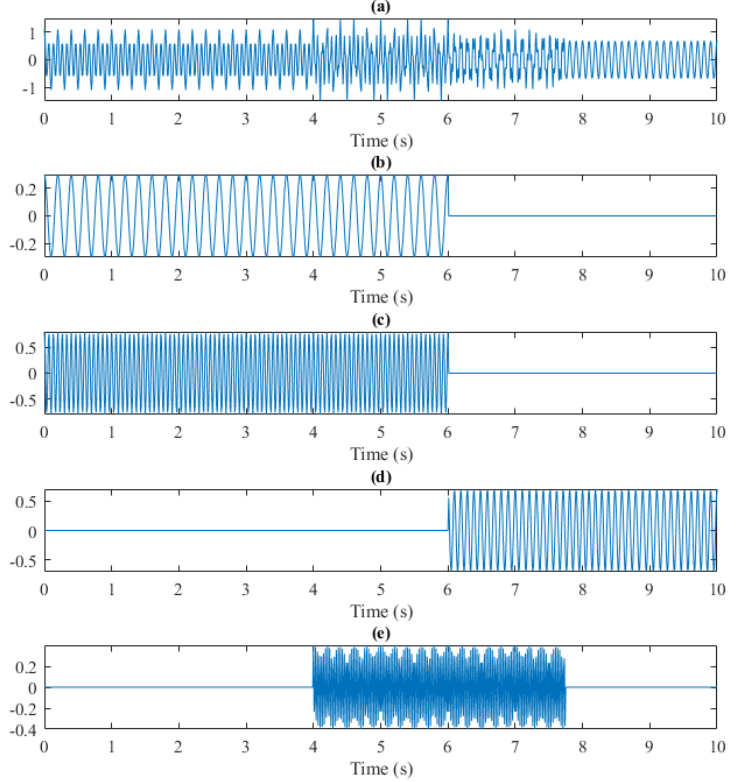
Figure 2. The synthetic data ( a ) composed of four sub-components ( b – e ). Remote Sens. 2018 , 10 , x FOR PEER REVIEW